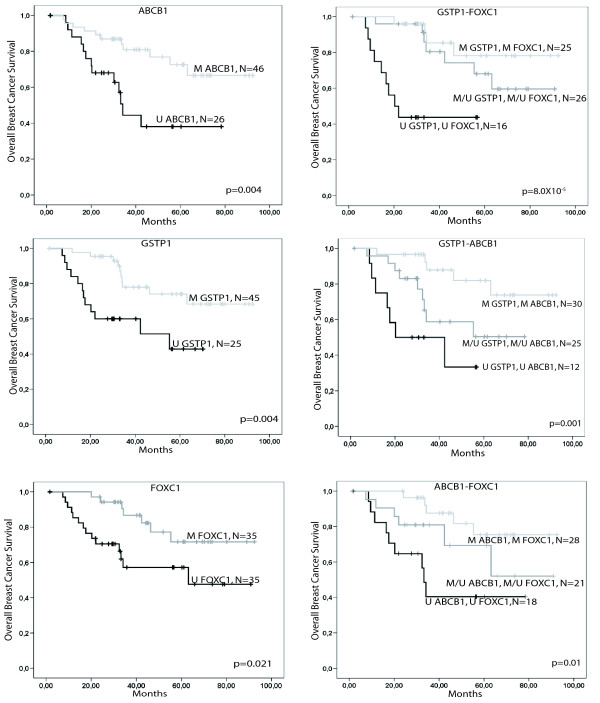
Kaplan-Meyer plots of overall survival. Kaplan-Meyer plots of overall survival for patients with either methylated or unmethylated GSTP1, FOXC1 or ABCB1 promoter, respectively (left column). Increased differentiation of patients is obtained through the use of two gene methylation panels, having both genes methylated, either of the two genes methylated and the other one unmethylated or both genes unmethylated (right column). The p-value was calculated using a log rank test and are given uncorrected. 'N' is the number of samples in each group. After Bonferroni correction, DNA methylation of GSTP1 and ABCB1 as well as GSTP1/ABCB1 and GSTP1/FOXC1 did reach the level of statistical significance. Deaths due to causes not related to breast cancer were censored.